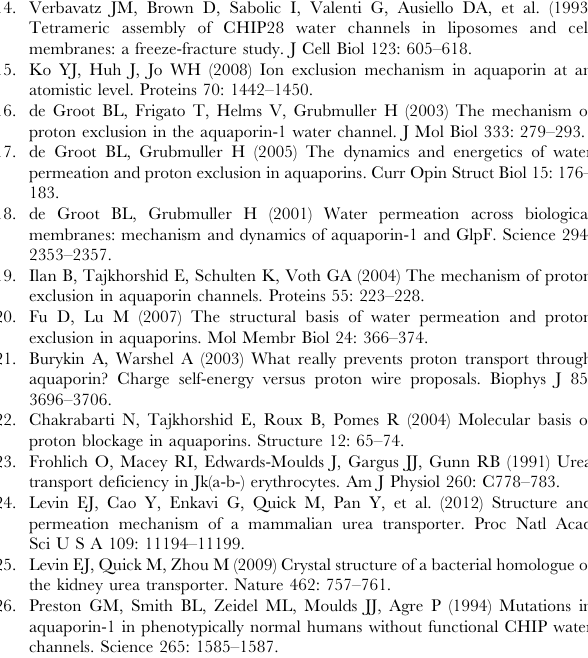
Figure S1 ProQM scores along the UT-B sequence. (TIF) Figure S2 Root Mean Square Deviation (RMSD) on C a atom versus time. RMSD on each simulation of human model in blue and in green, in red simulation of Bovine structure. (TIF) Figure S3 Inner product matrix on 10 first eigenvector of PCA. Matrix on transmembrane region of UT-B trimer (left). Matrix on transmembrane of a monomer (right). (TIF) Figure S4 Hydrogen bonds between water molecules depicted in Figure 7b and pore residues. The figure is given separately for clarity. (TIF) File S1 Construction and evaluation of structural model for the human sequence and simulation convergence.